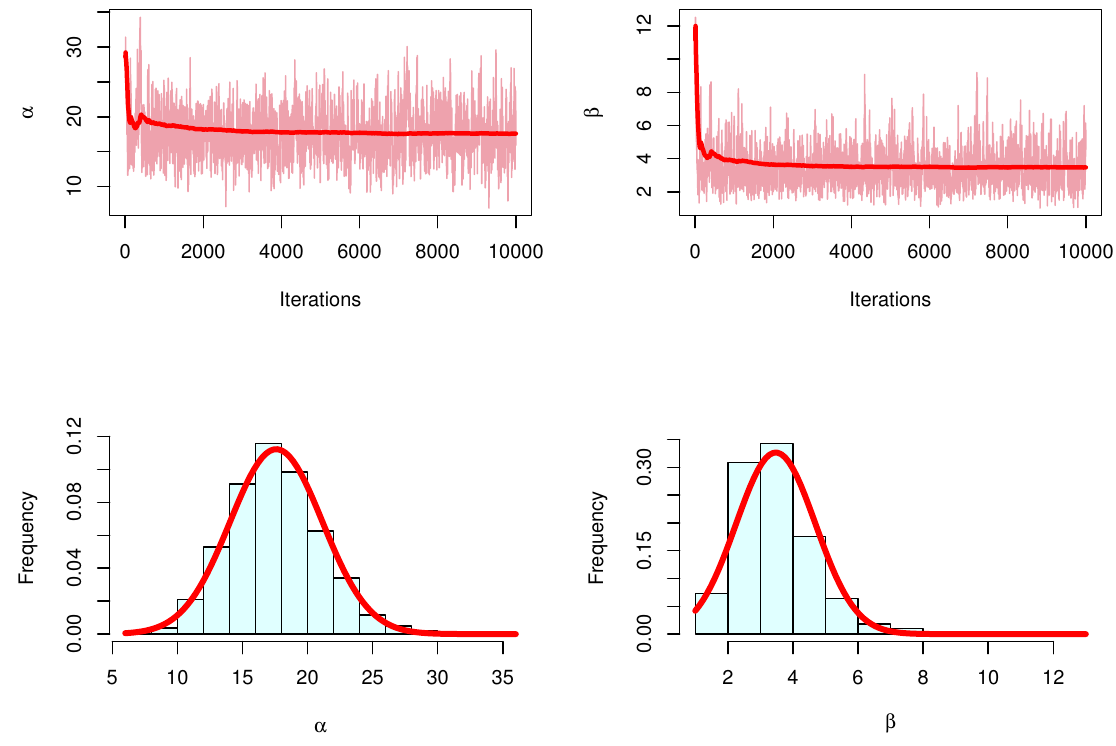
Figure 12. Trace and posterior density with normal curve for MCMC results: Data